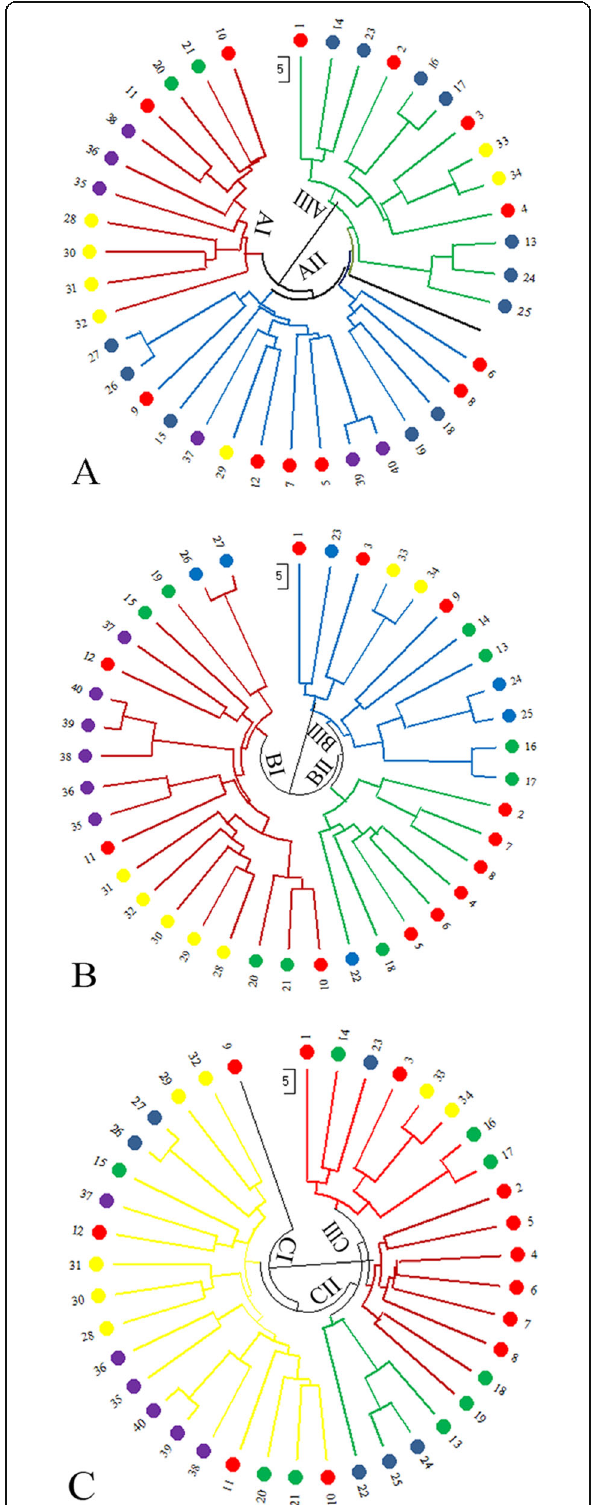
Fig. 2 Fan-dendrogram according to the Neighbor-joining method, evaluated with URP ( A ), SCoT ( B ), and SCoT URP ( C ) data. To see